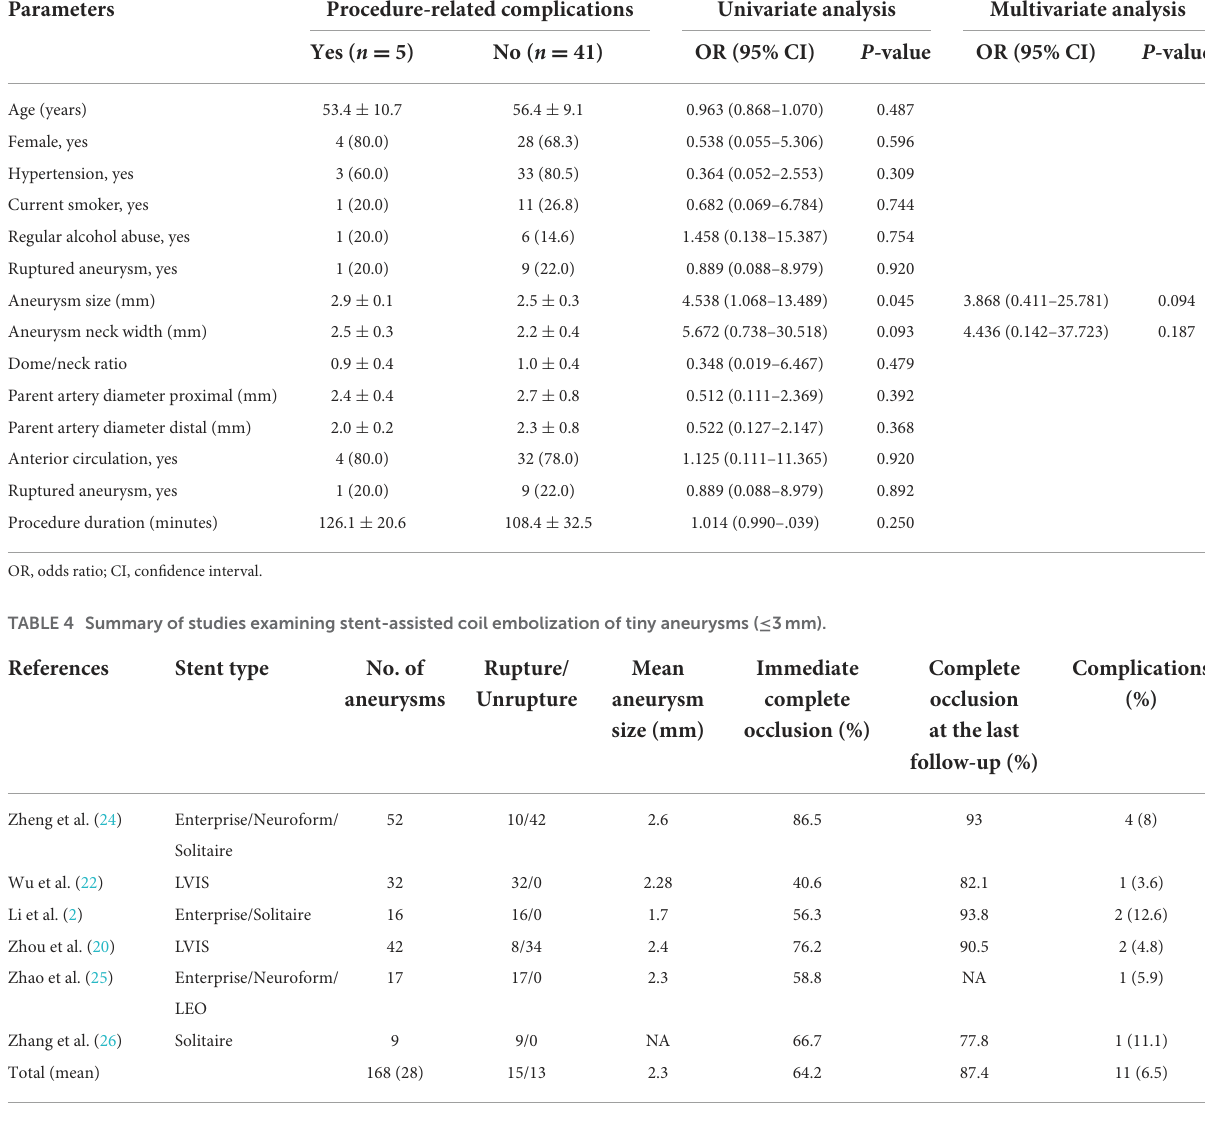
TABLE 3 Univariate and multivariate analyses of risk factors for procedure-related complications.